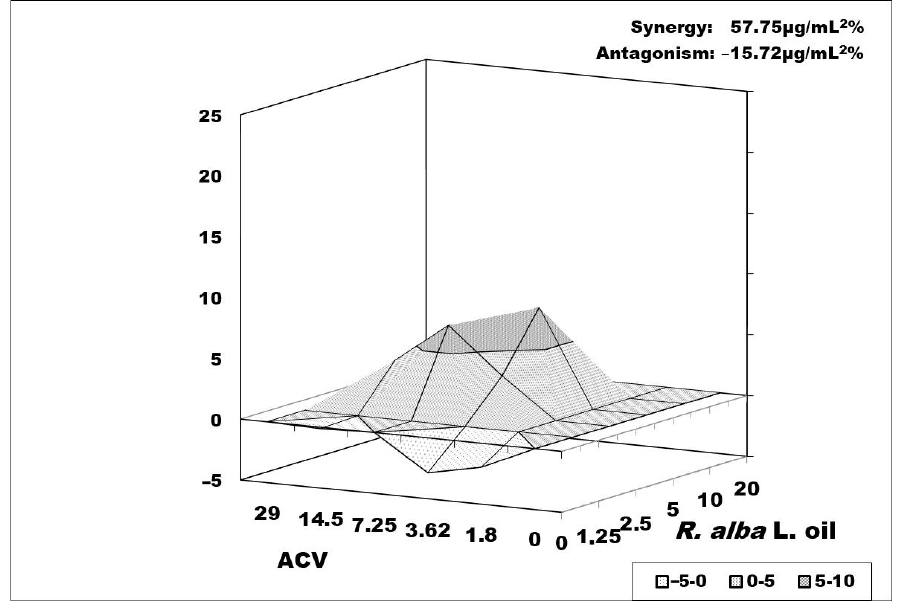
Figure 6. Combined effect of R. alba and acyclovir on HSV-1 replication (R-100 strain—resistant to ACV). Data processing is described in detail in Section 2.10.